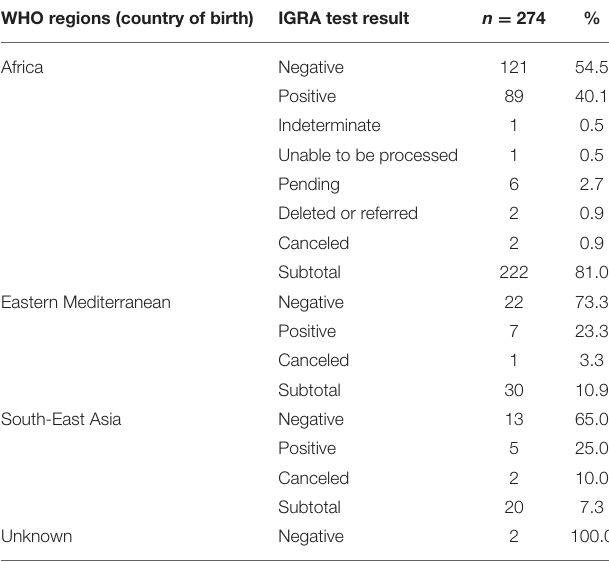
TABLE 3 | Sex, WHO region of the country of birth, and LTBI treatment outcome of adult refugees with IGRA test positive January to December 2015 at BridgeCare